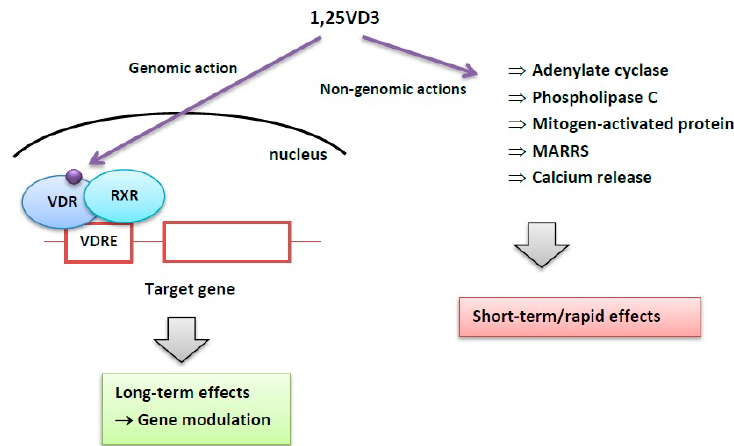
Figure 2. Genomic and non-genomic actions of vitamin D3. 1,25VD3 (1,25-dihydroxyvitamin D3)—active form of vitamin D; VDR, vitamin D receptor; RXR, retinoid X receptor; VDRE, vitamin D response element; MARRS, membrane-associated rapid-response steroid binding protein. The genomic action involves VDR—vitamin D receptor belonging to the nuclear receptors superfamily. VDR, while activated by 1,25VD3, dimerizes with the retinoid X receptor—RXR and this